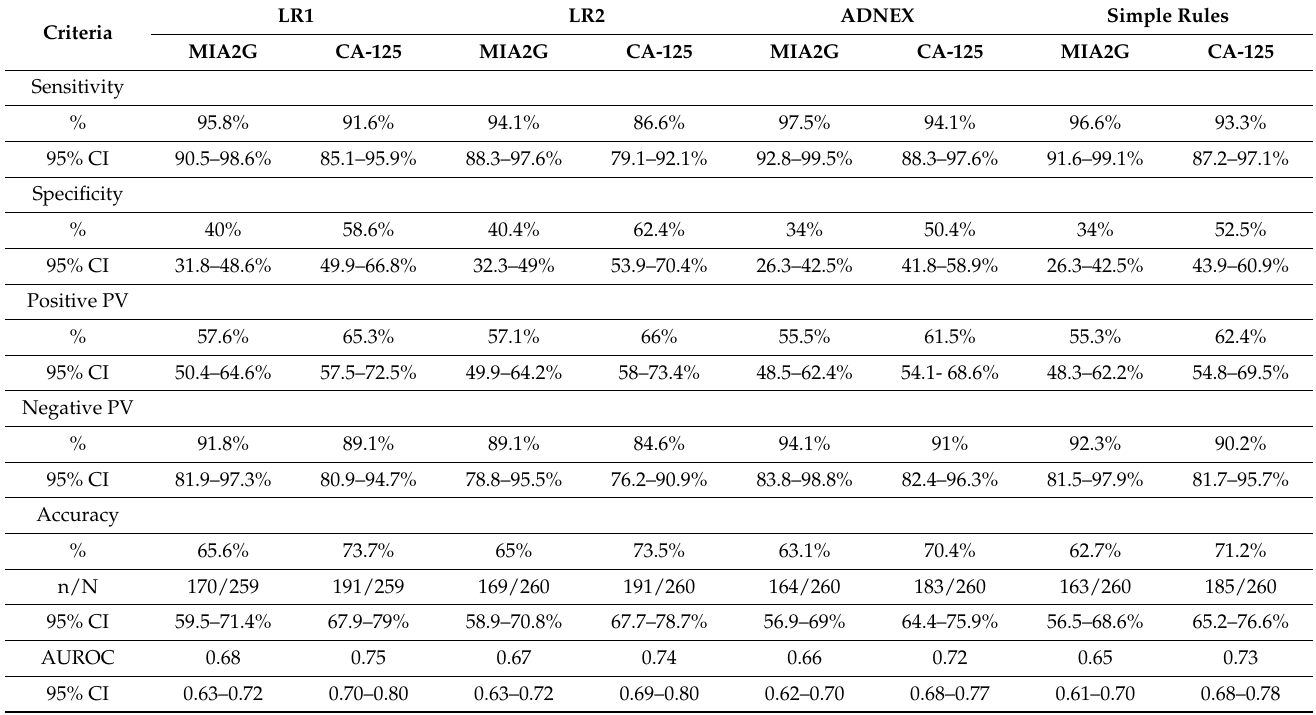
Table 4. Performance of parallel testing with biomarker assays and imaging in the prediction of ovarian